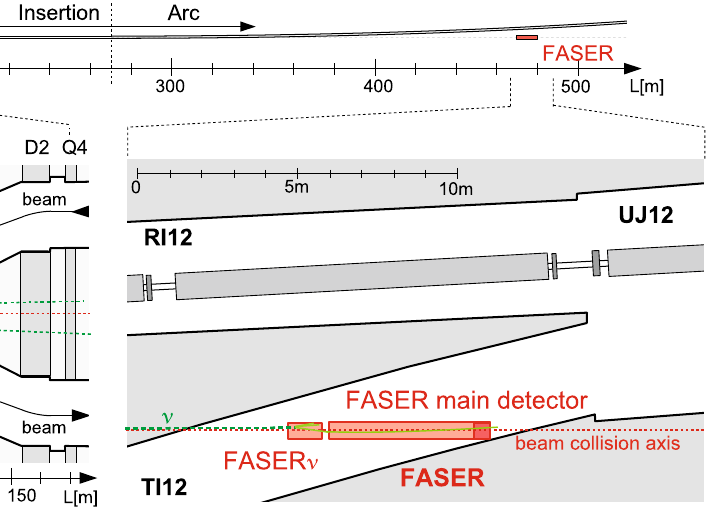
neutral particle absorber. Neutrinos (dashed lines) are produced either promptly or displaced and pass through the LHC infrastructure with- out interacting. Note the extreme difference in horizontal and vertical scales. Lower right panel : Neutrinos may then travel ∼ 480 m further downstream into tunnel TI12 and interact in FASER ν , which is located at the front of the FASER main detector